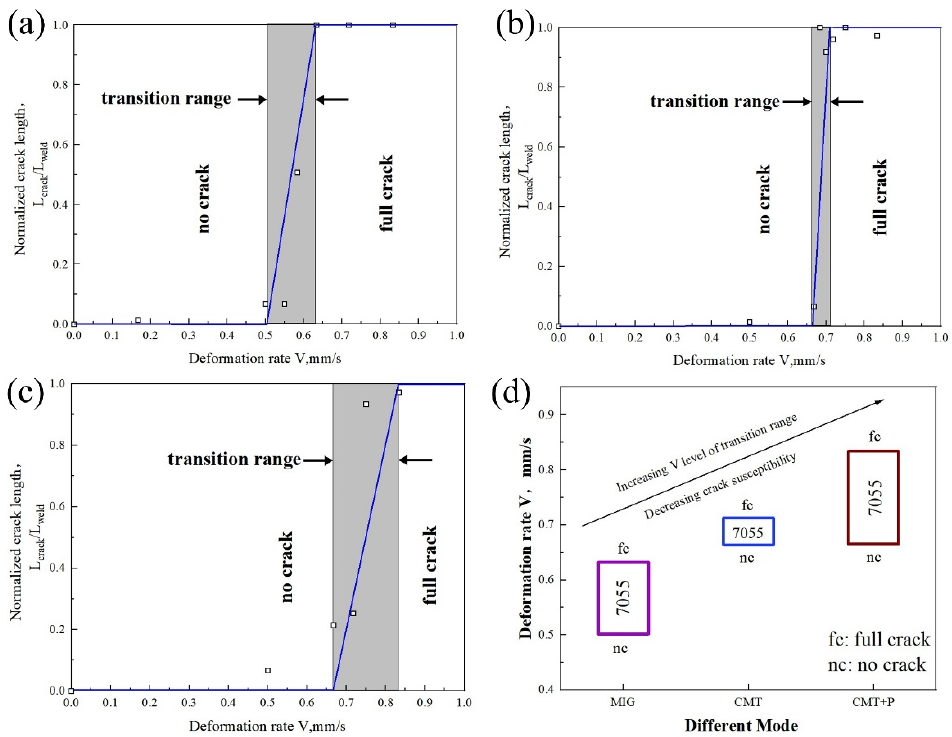
Figure 11. Test results of 7075 Al welded with 7055 Al as filler metal: ( a ) MIG mode; ( b ) CMT mode; ( c ) CMT+P mode; ( d ) comparison among different arc modes.